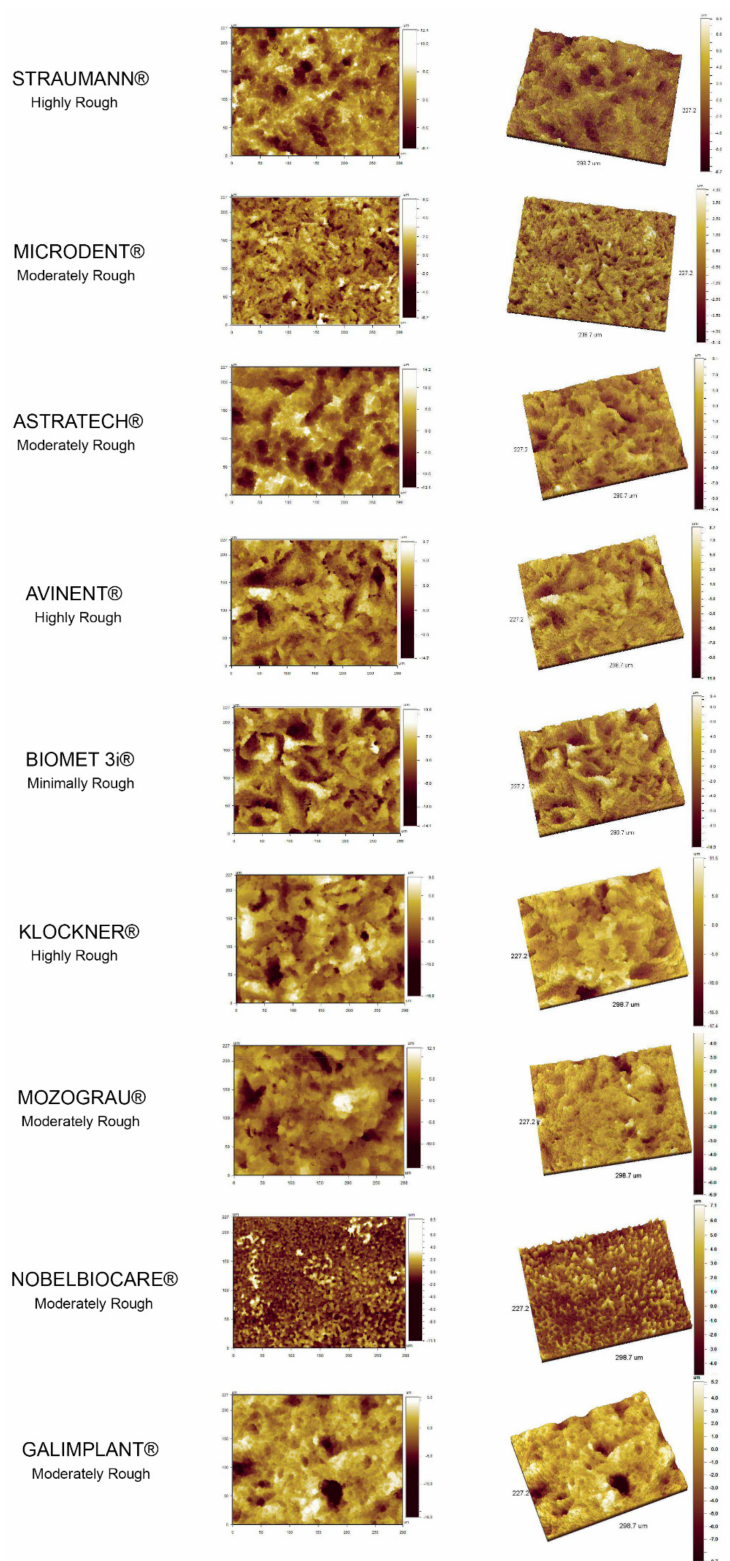
Figure 2. 2D and 3D images of the topographic reconstruction of the implant surface for each of the nine implant systems evaluated, obtained from the white light optical interferometry (WLOI) with a magnification of 20 ×